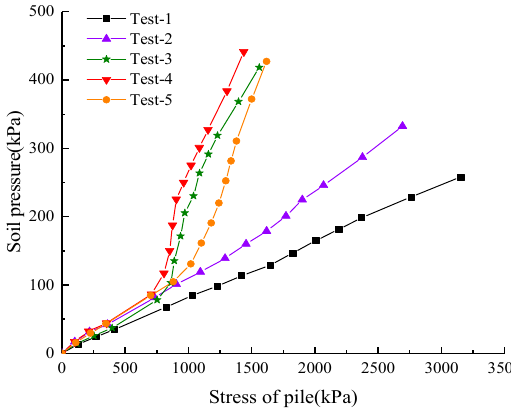
Figure 6. Curve of pile top stress–soil pressure.